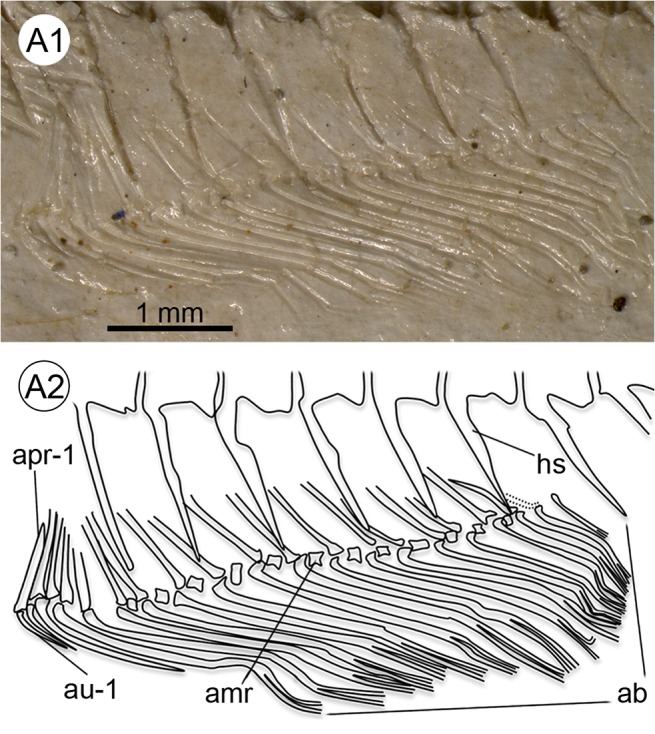
Details of the anal fin of †Kenyaichthys kipkechi sp. nov. (paratype 1177´04).
A1–A2 Anal fin with three short rays, 17 long rays and 19 proximal radials (last ray not supported by proximal radial), left lateral view. Abbreviations: ab, branched rays of anal fin; amr, anal medial radial; apr-1, first anal proximal radial; au-1, first unbranched anal fin ray; hs, haemal spine.